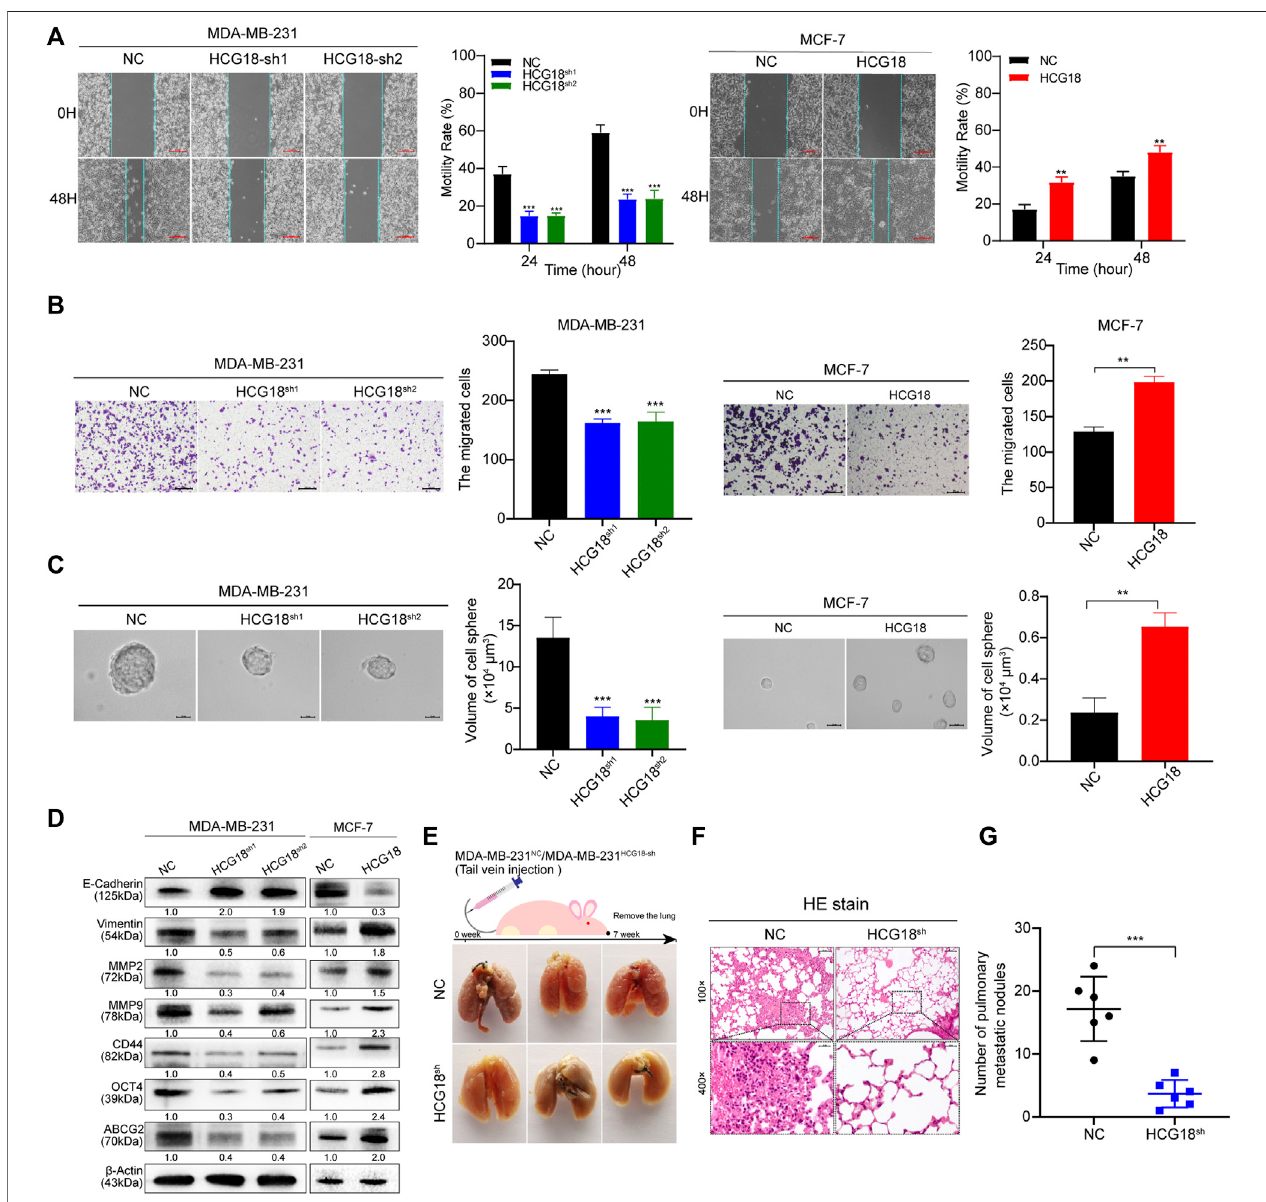
FIGURE 3 | (A) Wound healing assays were performed to detect the effect of HCG18 on the migration ability of BC cells (scale bar, 200 μ m). (B) The invasion capability of MDA-MB-231 NC /MDA-MB-231 HCG18-sh and MCF-7 NC /MCF-7 HCG18 cells was assessed by Matrigel invasion assays (scale bar, 200 μ m). (C) The spheroid formation capabilities of BC cells after changing HCG18 expression were examined by tumor sphere formation assays (scale bar, 20 μ m). (D) The expression levels of EMT markers (E-cadherin and vimentin), metastatic markers (MMP-2 and MMP-9), and CSP markers (CD44, OCT4, and ABCG2) were determined by Western blotting assays. (E – G) Lungs excised from mice in the MDA-MB-231 NC /MDA-MB-231 HCG18-sh lung metastatic models were photographed (E) and subjected to HE staining (F) ,andthenthelungmetastasisnodeswereanalyzed (G) .Thedataareshownasthemean ± SD.* p < 0.05,** p < 0.01,*** p < 0.001.Thedatarepresentatleast three independent